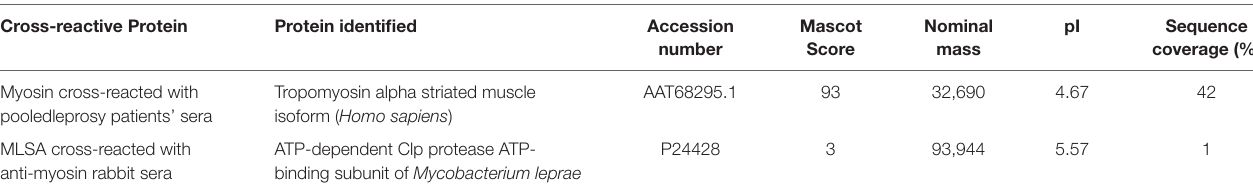
TaBle 2 | Cross-reactive proteins identified by MALDI-TOF. cross-reactive Protein